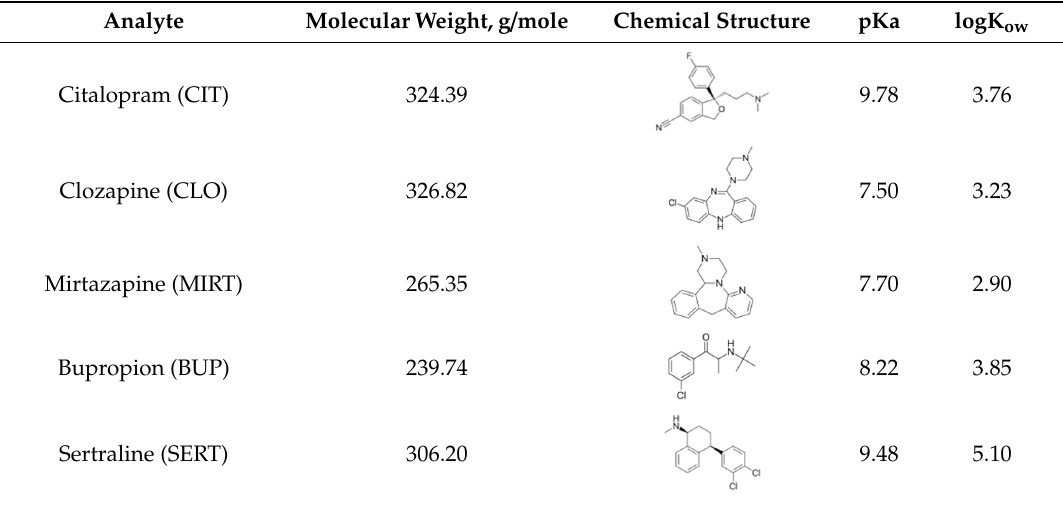
Table 1. Structures and respective physico-chemical characteristics of target analytes.